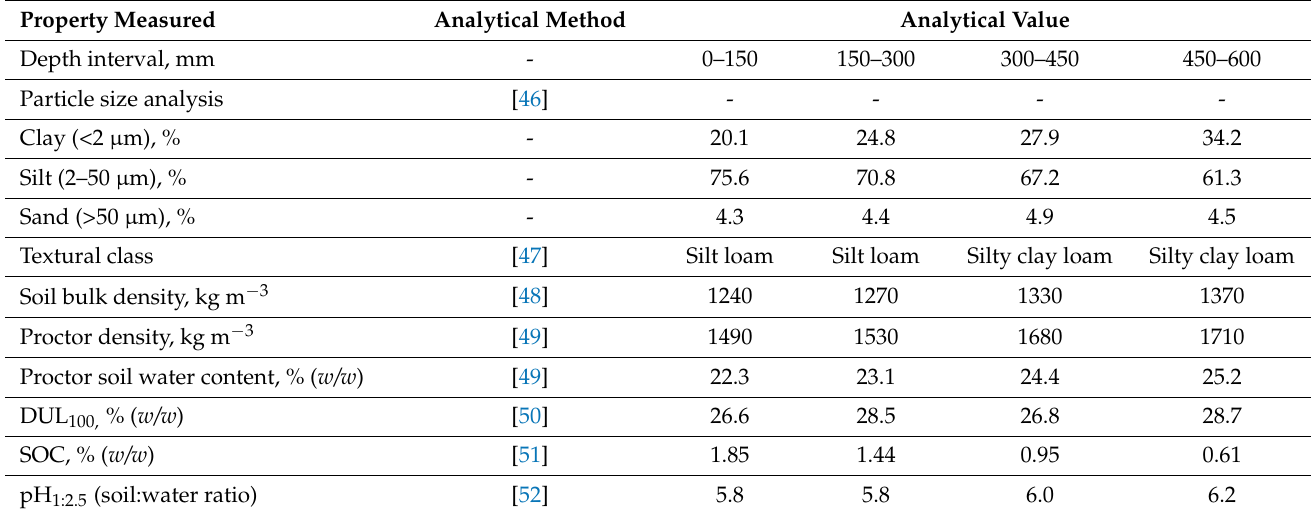
Table 1. Characterisation of the soil (Typic Argiudoll) from the experimental site near Lujan (Buenos Aires, Argentina). DUL 100 is drained upper limit measured at 100 cm suction and is considered to be the laboratory determination of field capacity; SOC is soil organic carbon. Values are means of five determinations ( n =